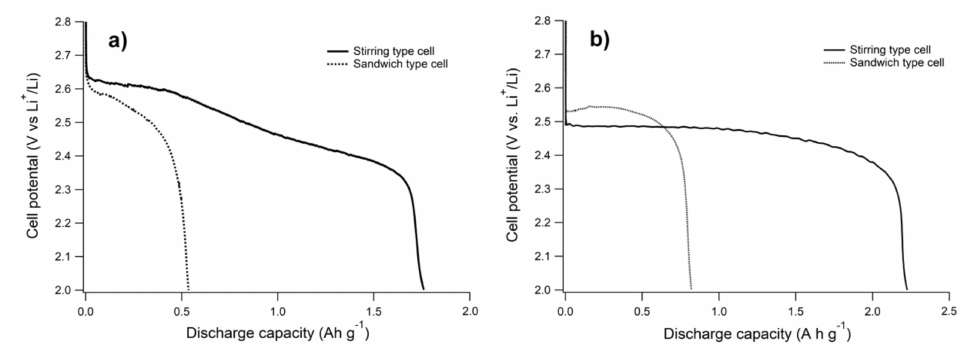
Figure 7. Discharge capacities of MC ( a ) and MMC-1( b ) / SS mesh electrodes at 60 ◦ C at 0.1 mA cm − 2 using a sandwich and a bulk cell